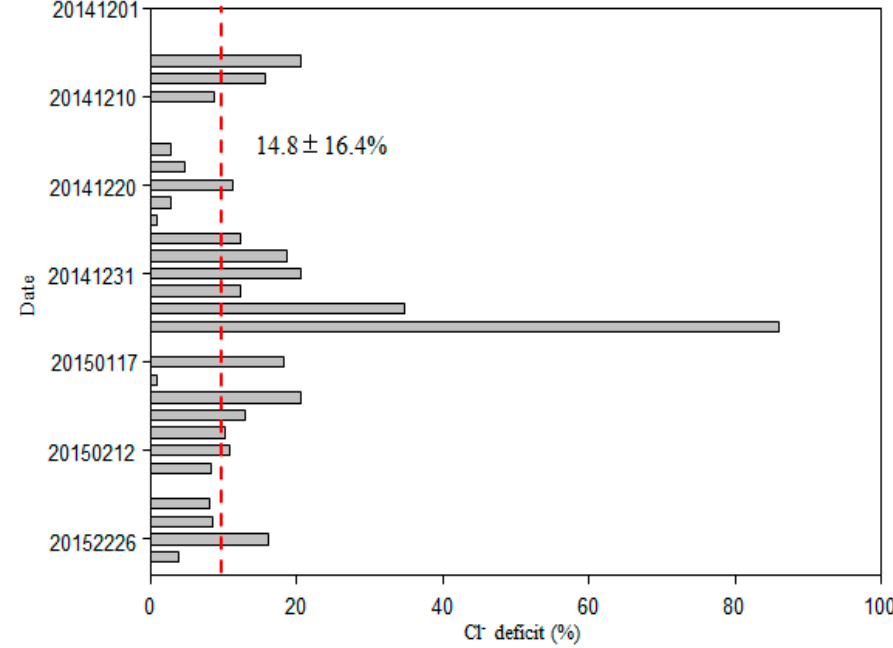
Figure 5. Percent Cl − deficit at different sites, with the dashed line for the averaged value.